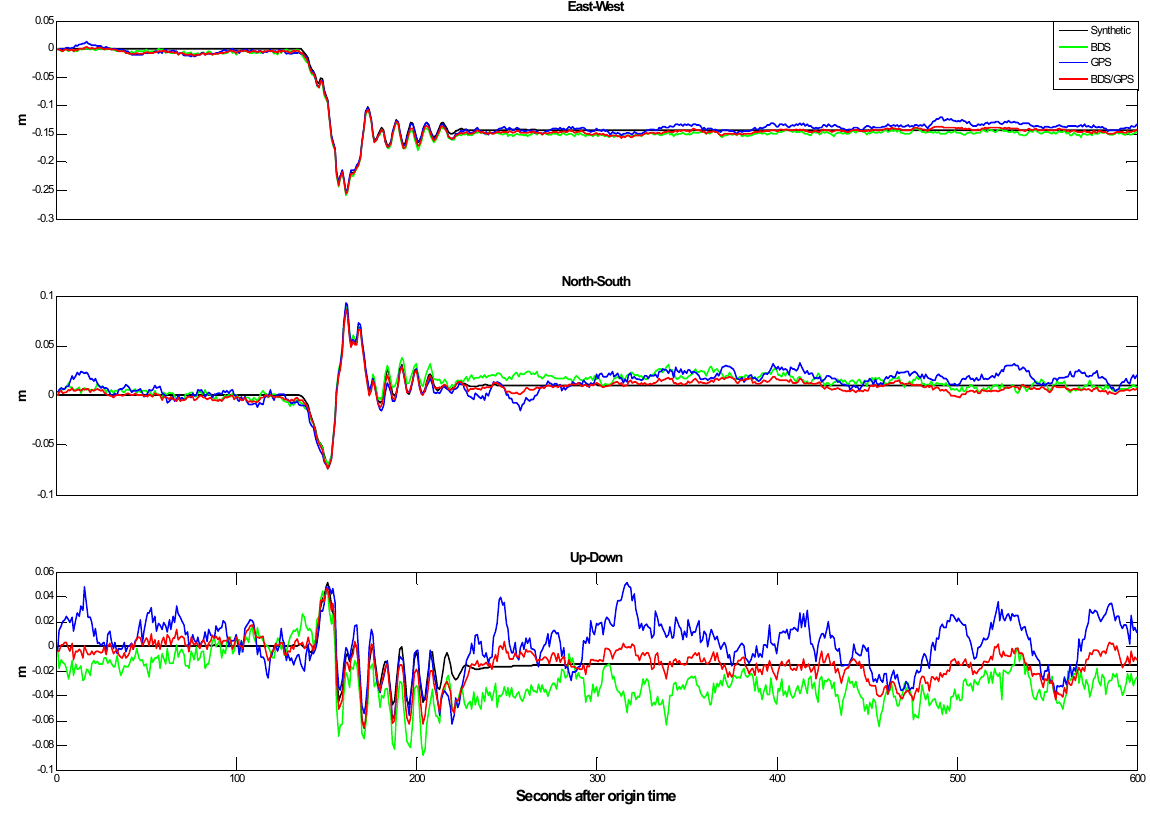
Figure 3. Simulated displacement waveforms in forward-model scenario (rupture E2, see text for description). Waveforms are shown at one selected virtual GNSS-station placed at the Luzon Island (contoured triangle on Figure 4a). Black lines represent original kinematic simulations; colored lines represent the simulations after an addition of typical TPP processing noise (Secion 2). “Noisy” displacements will be used for source inversion.